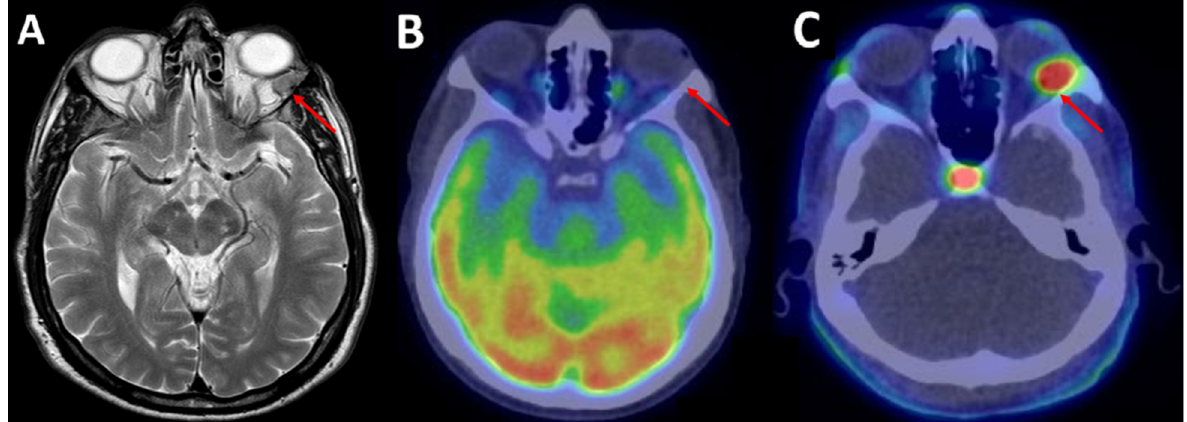
Figure 1. A 69-year-old male patient with a second loco-regional recurrence of left supraorbital solitary fibrous tumor. ( A ) A brain MRI scan revealed on axial MRI T2c+ a rounded lesion on the lateral side of the left orbit, strongly suspected of disease relapse (red arrow). ( B ) Two weeks later, 18 F-FDG PET/CT showed no radiopharmaceutical uptake in the left supraorbital region (red arrow). ( C ) Conversely, after seven days, 18 F-FCH PET/CT showed intense uptake in the aforementioned lesion (red arrow; SUVmax